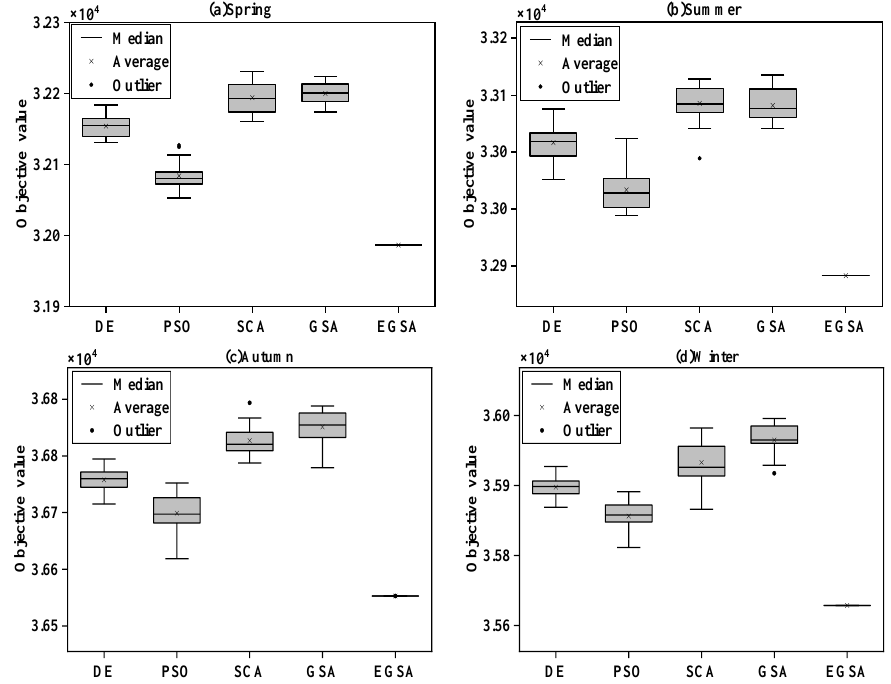
ff erent cases for peak